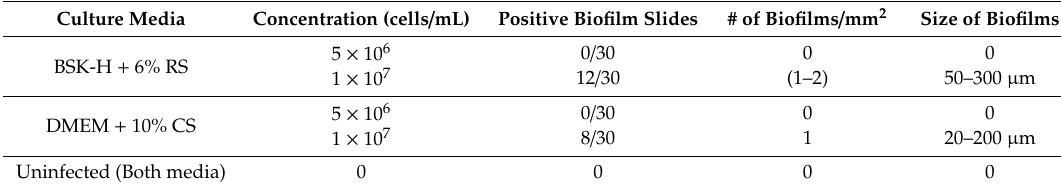
Table 2. Quantitative summary of biofilms found in B. burgdorferi -inoculated murine skin biopsies and cultured in BSK-H + 6% RS and DMEM + 10% CS.